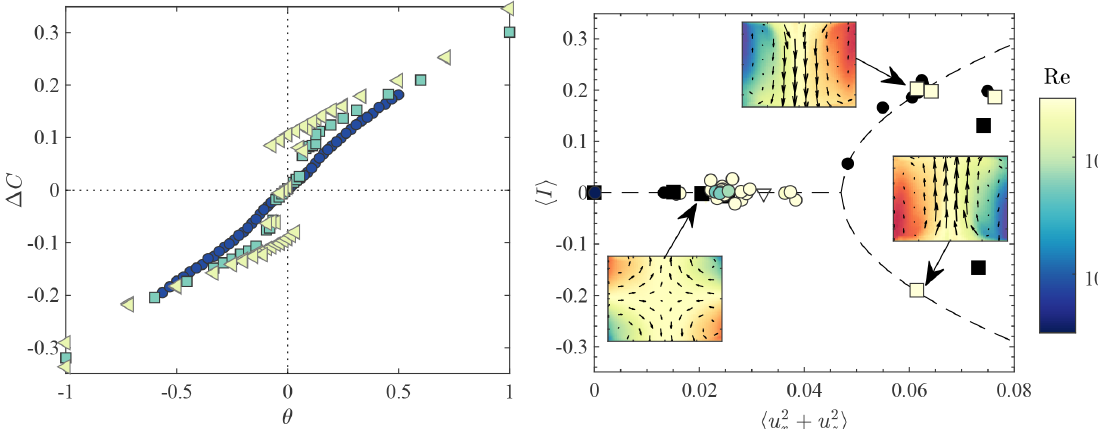
Figure 10. Disappearance of the bifurcation when the Reynolds number or the fluctuations are decreased. (a) Difference between the non- dimensional torque applied by the turbulence on the upper and lower impellers (cid:49)c as a function of θ , shown for various Reynolds numbers. Blue circles: Re = 980; green squares: Re ∼ 5600; yellow triangles: Re = 11000. The quantity (cid:49)c is a proxy of (cid:104) I (cid:105) . We see that the transition between the two summer states is discontinuous for Re > 5600 but becomes continuous at a low Reynolds number (figure adapted from Rav- elet, 2005). (b) Linking the hysteresis cycle properties to the velocity fluctuations in the von Kármán flow following Thalabard et al. (2015). (cid:105)−(cid:104) u φ (cid:105) 2 measured in our Coloured symbols: mean vertical angular momentum (cid:104) I (cid:105) as a function of the energy of azimuthal fluctuations (cid:104) u 2 φ experiment at θ = 0 for different impeller shapes and Reynolds numbers. The black symbols are (cid:49)c at θ = 0 at different Reynolds numbers (cid:105)−(cid:104) u φ (cid:105) 2 = 0 . 05, two branches of the circulation exist; the lower branch corresponds to austral and for different propeller shapes. Above (cid:104) u 2 φ (cid:105)−(cid:104) u φ (cid:105) 2 < 0 . 05, the austral summer, while the upper branch corresponds to boreal summer. The spring/autumn branch is unstable. For (cid:104) u 2 φ (and boreal) summer branches disappear, and we observe only one possible state of the circulation corresponding to the spring/autumn branch (picture adapted from Thalabard et al., 2015).